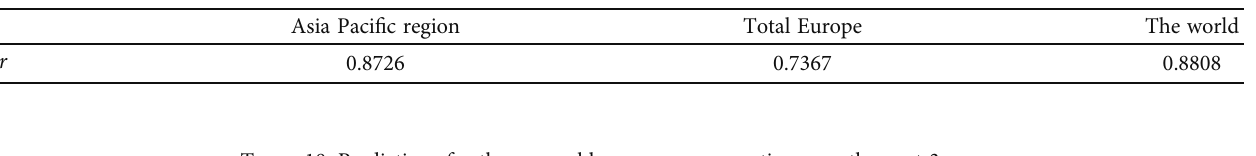
Table 17: Optimal parameter values of renewable energy consumption.